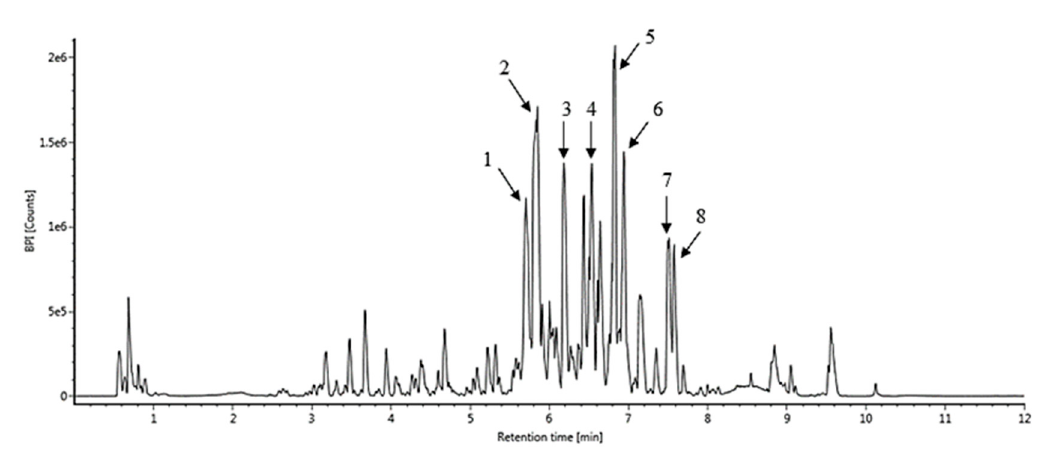
Figure 2. Results of chromatogram after UPLC-MS / MS analysis of chemical compounds of nutmeg extract.